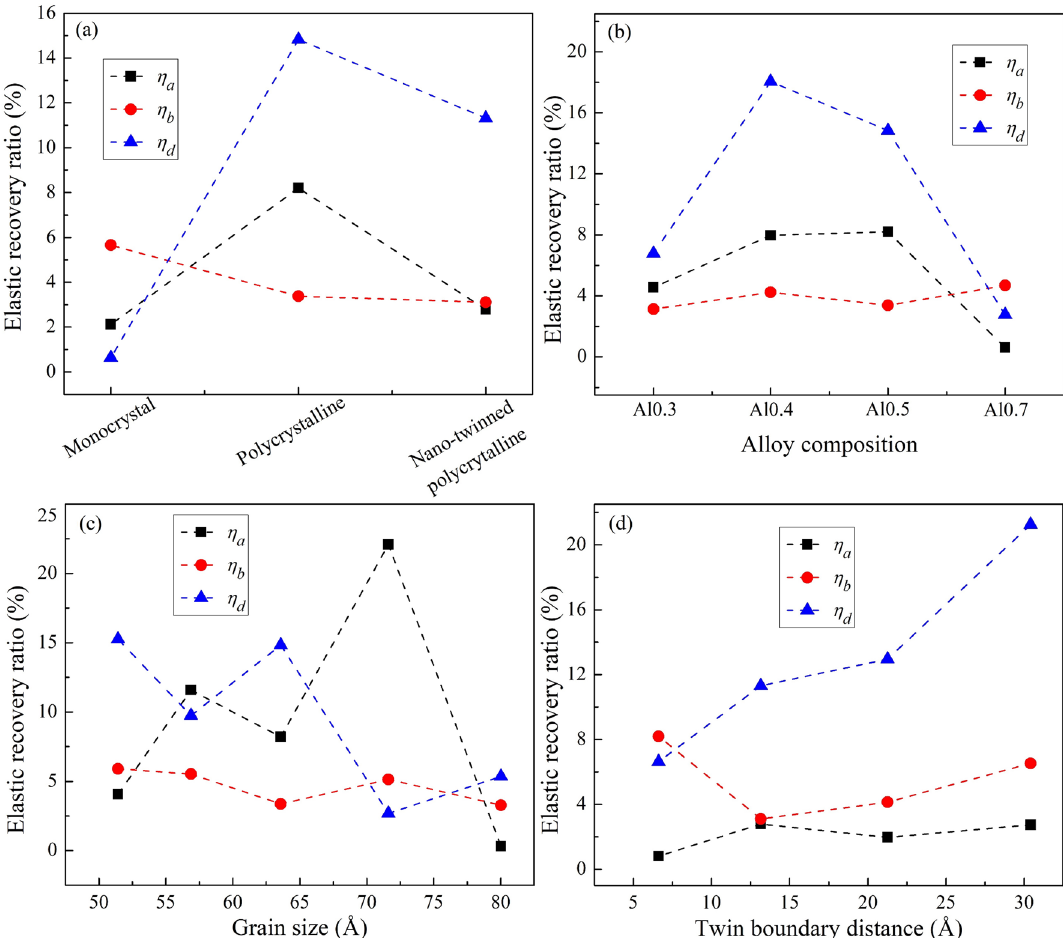
Figure 15. The elastic recovery ratio for various parameters: structures ( a ), alloy compositions ( b ), grain sizes ( c ), TB distances ( d